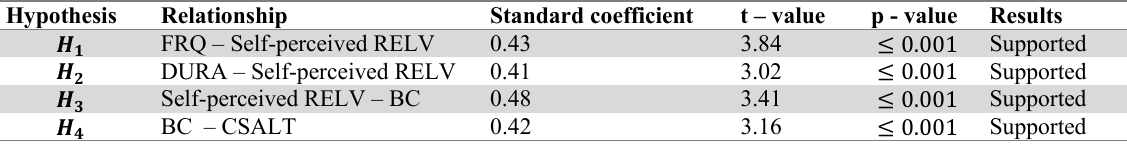
Results of hypotheses